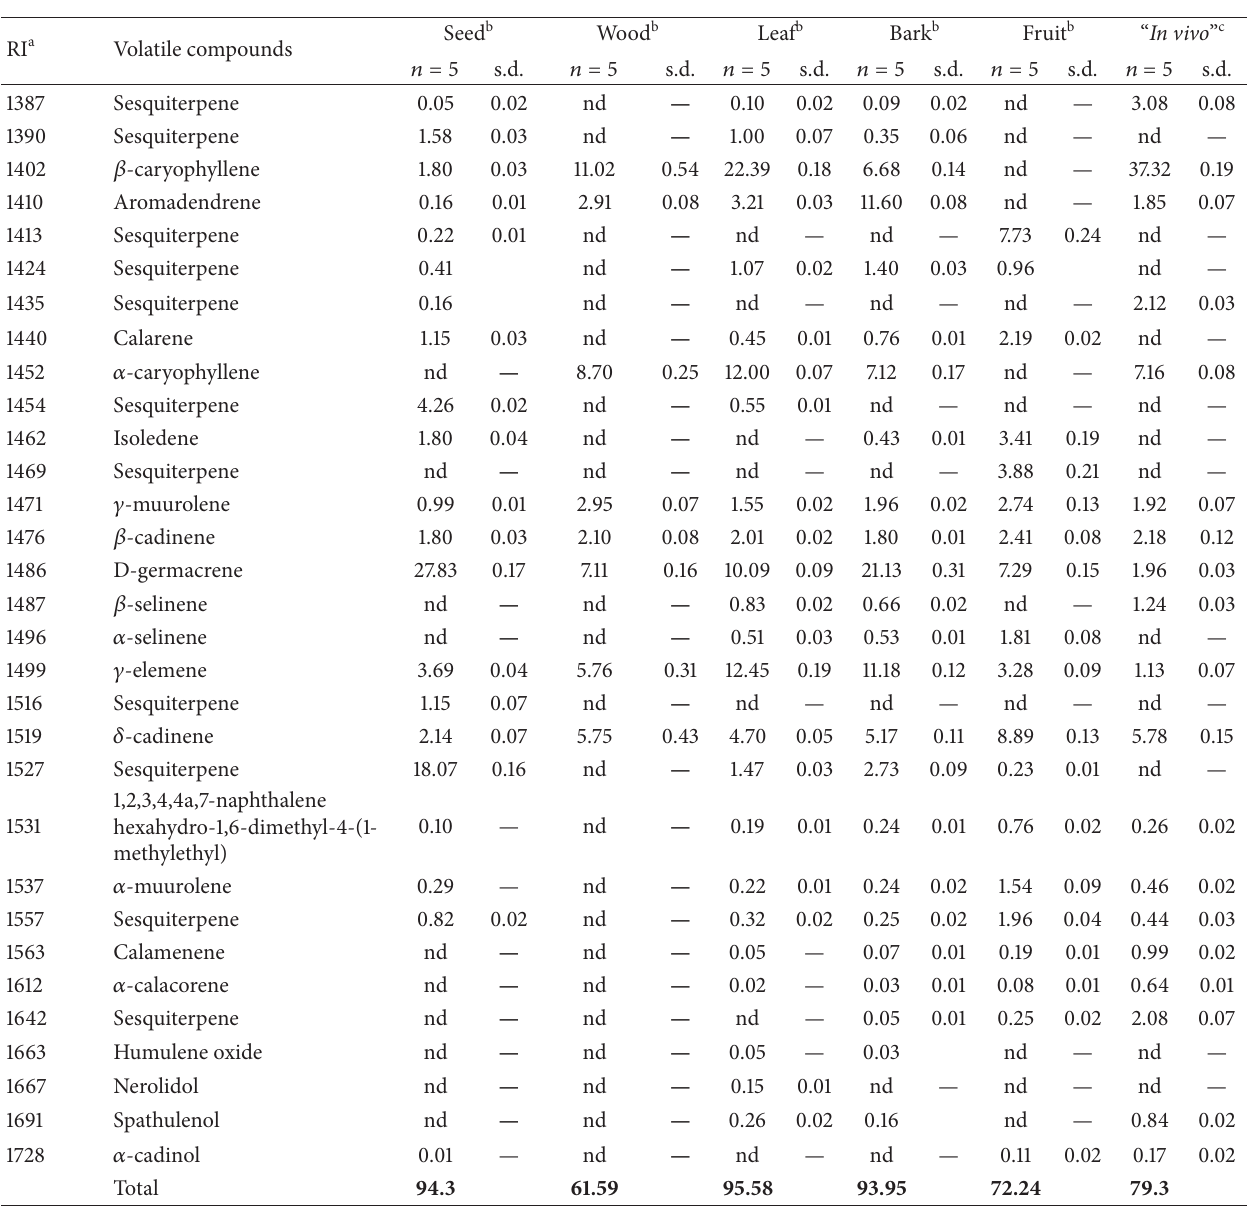
a The Kovats retention index calculated for Rtx-Wax capillary column (25m × 0.25 𝜇 m × 0.25mmi.d.). b Normalizedamountofvolatilecompounds(percentage);(peakofvolatilecompound/totalpeakareaofallvolatilecompounds)of B.orellana (𝑛 = 3 )obtained from different parts. c Normalized amount of volatile compounds (percentage); (peak of volatile compound/total peak area of all volatile compounds) of B. orellana living plants using in vivo sampling ( 𝑛 = 3